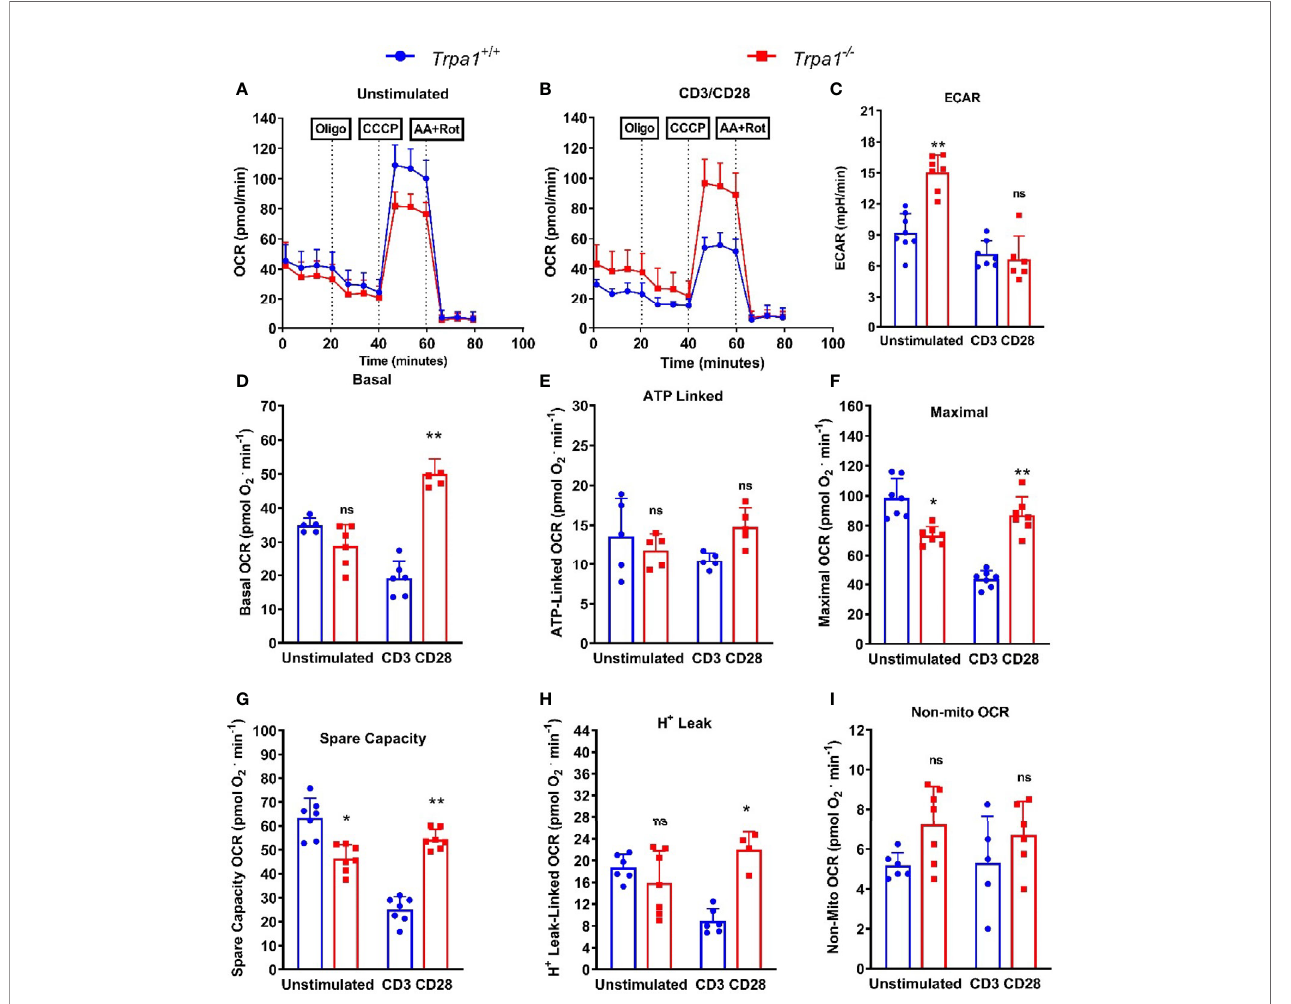
FIGURE 6 | Mitochondrial metabolic evaluation from spleen-derived Trpa1 +/+ or Trpa1 -/- T CD8 lymphocytes under CD3/CD28 activation. (A) Traces obtained from unstimulated` Trpa1 +/+ or Trpa1 -/- T CD8 cells after injections of oligomycin (ATP synthase inhibitor), CCCP (uncoupler) and antimycin A plus rotenone (Complex III and I inhibitors); (B) Same as in A but cells were stimulated for 30 min using immobilized CD3/CD28; (C) Extracellular acidi fi cation rate (ECAR) from unstimulated and stimulated cells; (D) Basal respiration; (E) ATP-linked oxygen consumption rate; (F) Maximal oxygen consumption rate; (G) Spare capacity (difference between maximal and basal respiration); (H) Proton-leak linked oxygen consumption rate; (I) Non-mitochondrial respiration (this part is subtracted from all the other respiration rates shown in D – H ). Values are presented as the mean (n = 8) ± SD of each group. *p < 0.05; **p < 0.01. One-Way ANOVA analysis followed by Tukey was performed to evaluate differences between conditions and